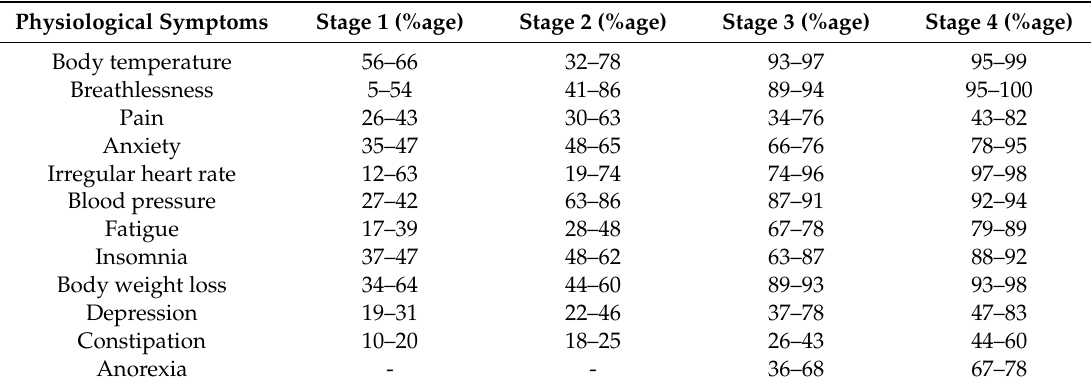
Table 2. Symptoms appear at di ff erent stages in lung